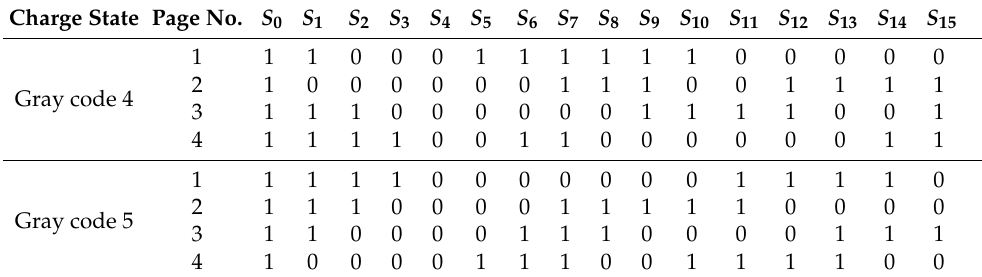
Figure 7. GC codes of rate R = 0.87 with 2 kB of payload data code for TLC model with pagewise and joint decoding using Gray code 1 ( left ) and Gray code 2 ( right ). Table 7. Possible Gray code bit-labeling for a QLC flash